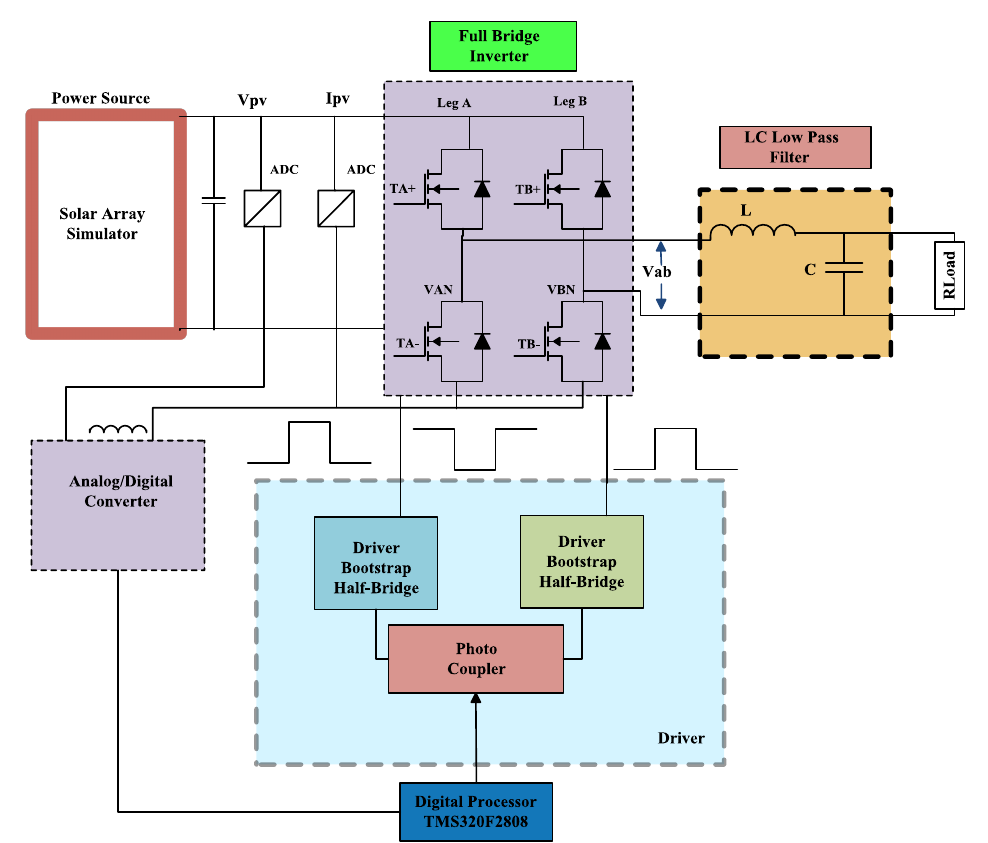
Figure 9. A full bridge inverter scheme with low pass filter and DSP controller for BRPVS.